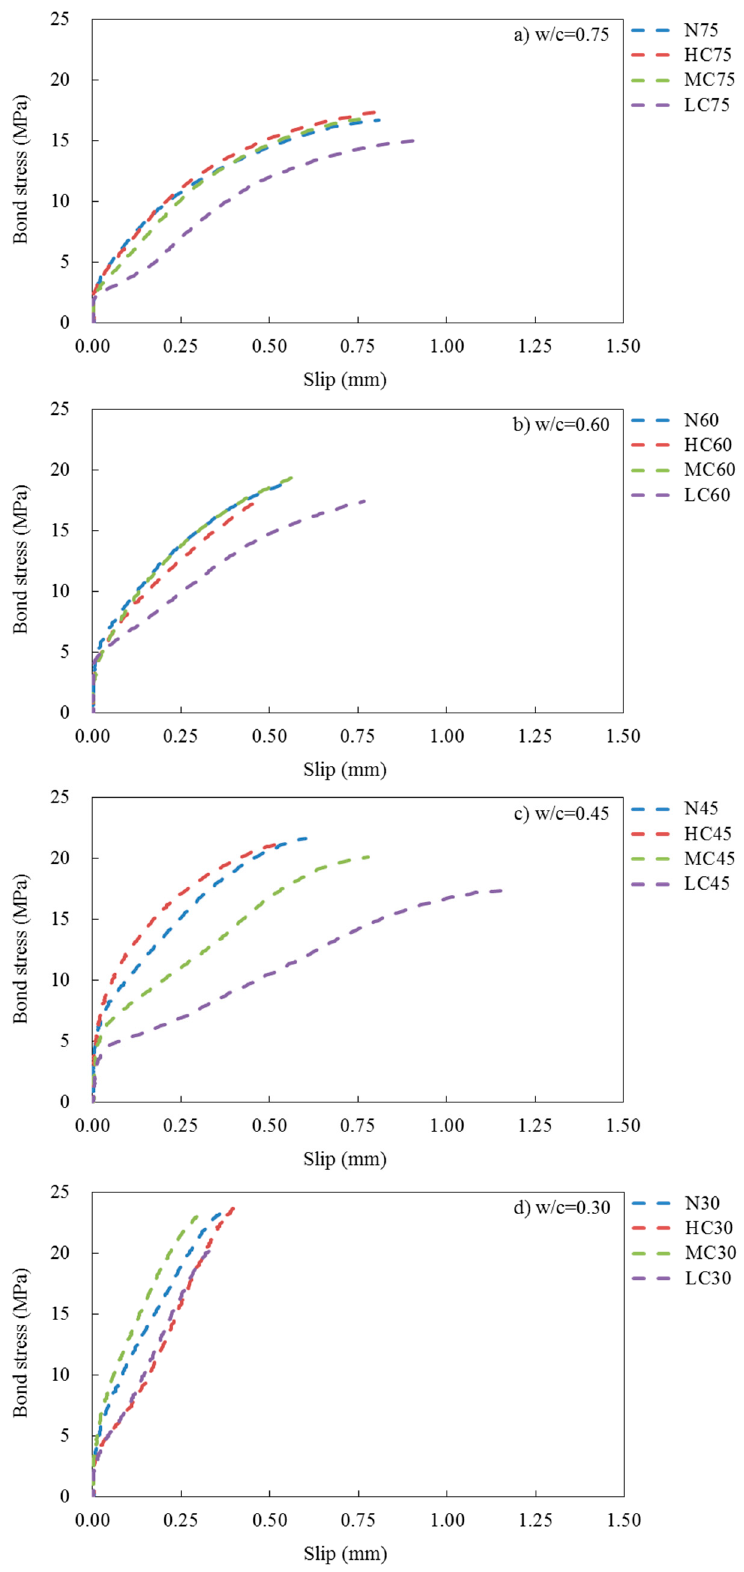
Figure 15. Bond stress-slip relationship of the concrete with a 19-mm-diameter steel rebar with different water-to-cement ratios. ( a ) For w/c = 0.75; ( b ) for w/c = 0.60; ( c ) for w/c = 0.45; ( d ) for w/c = 0.30.